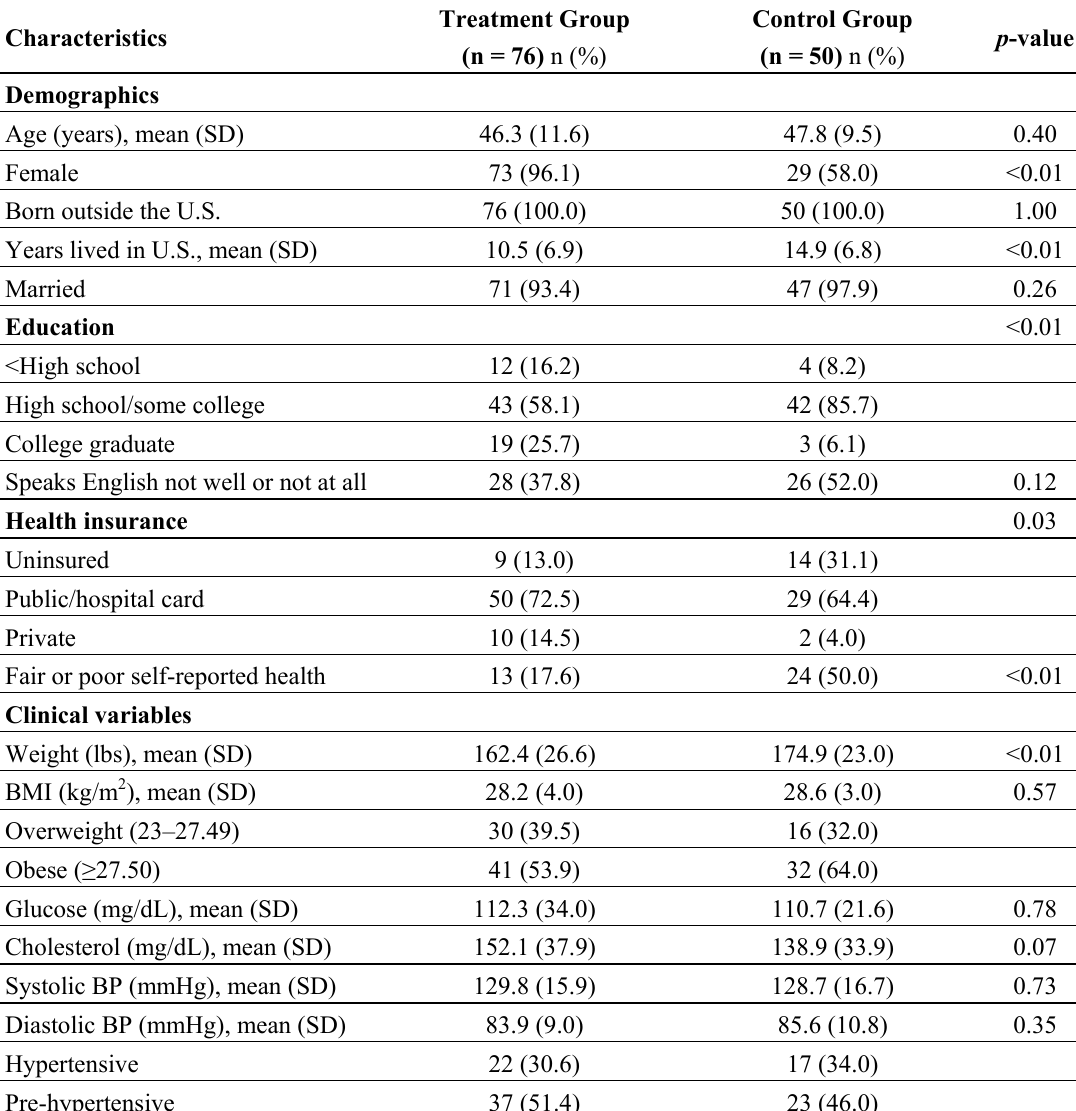
Table 3. Baseline characteristics of participants (n =